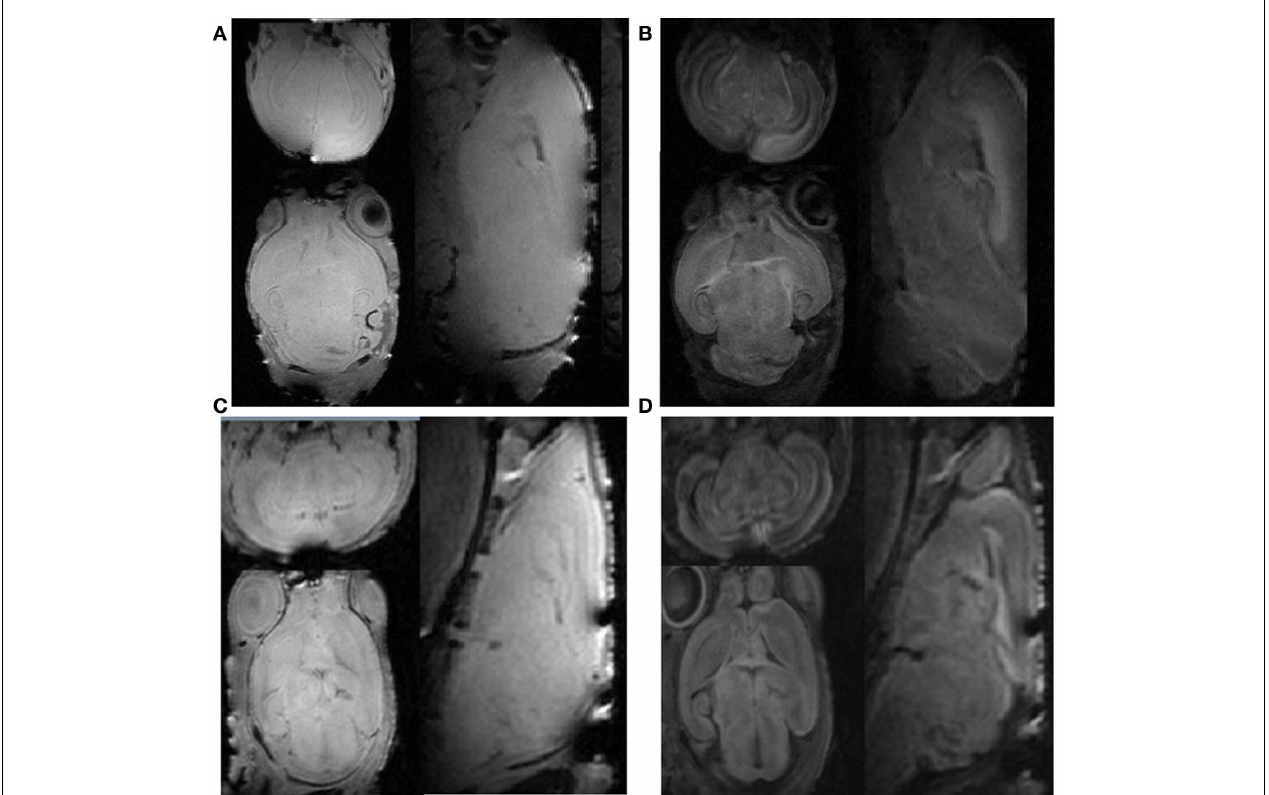
FIGURE 1 |The comparison of b = 0 and diffusion weighted images between the ex vivo scan and the in vivo scans. (A) Ex vivo baseline b = 0 image; (B) ex vivo diffusion weighted image; (C) in vivo baseline b = 0 image; (D) in vivo diffusion weighted image.The axial, sagittal, and coronal plane images are shown